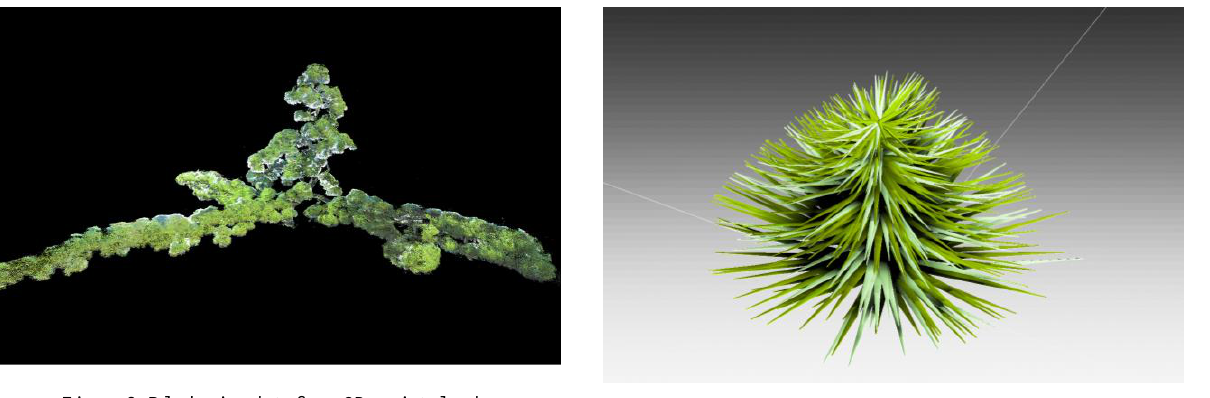
Figure 10. 3D model of acerose leaf